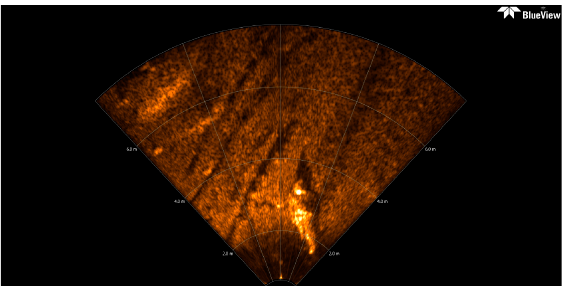
Figure 8. The original FLS image comes from [48], and there is a plastic mannequin in the down center. The size of the converted FLS imagery is 1920 × 932 = 1,789,440 pixels, the area size of the background spots is usually fewer than 40 pixels, with gray levels similar to those of certain areas of the foreground objects. In this case, N 40 is defined as the number of contours which area size is smaller than 40 pixels, and it is computed by the Canny contour detection algorithm. If N 40 > 600, (1,789,440/40 × 600 = 74.6:1), this assigned threshold 74.6 is higher than that of 71.1 for the former